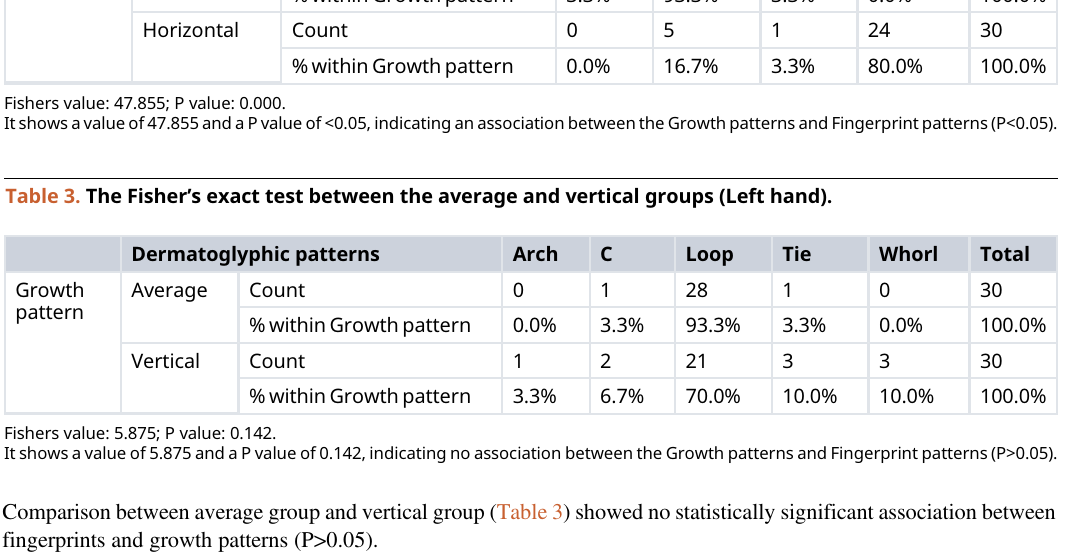
Comparison between average group and vertical group (Table 3) showed no statistically significant association between fingerprints and growth patterns (P>0.05). Comparison between the horizontal group and the vertical group (Table 4) showed a statistically significant association between fingerprints and growth patterns (P<0.05). Right hand With respect to the right hand, average growers had the loop pattern as the most dominant pattern with a frequency percentage of 93.3%. There were 6.7% of the population that showed a tie between two patterns (Table 5).